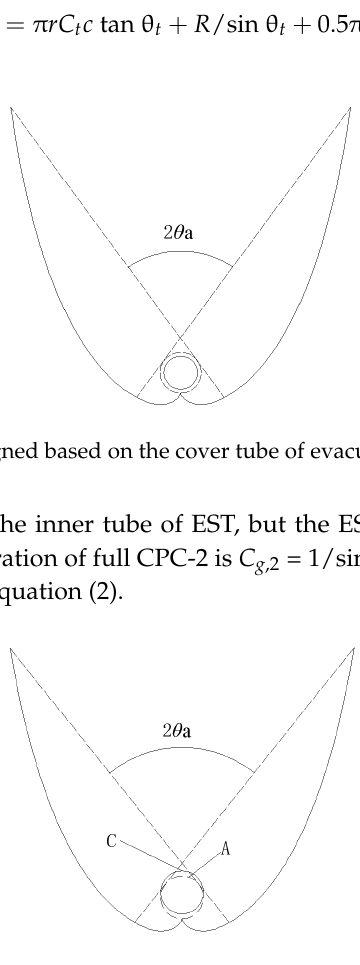
Figure 3. CPC-2, designed based on inner tube with the EST purposely being moved up R - r